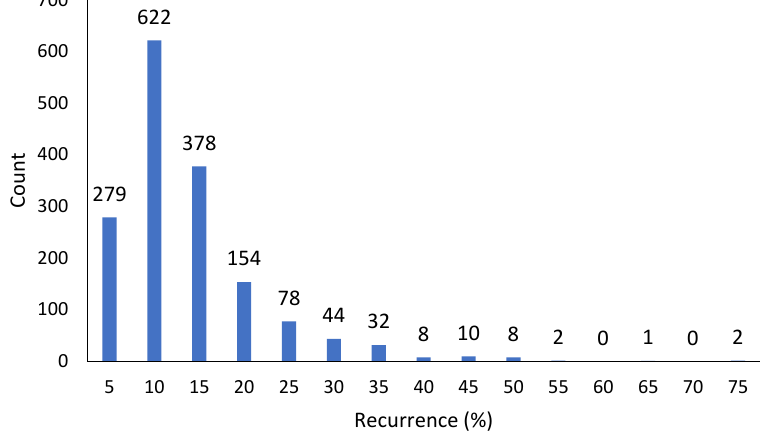
Figure 7. Frequency distribution of seep zone recurrence rates.